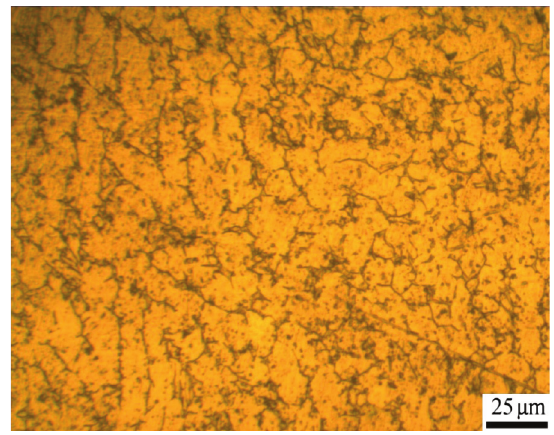
Figure 1 : Micrograph of as-received Ti – 6Al –